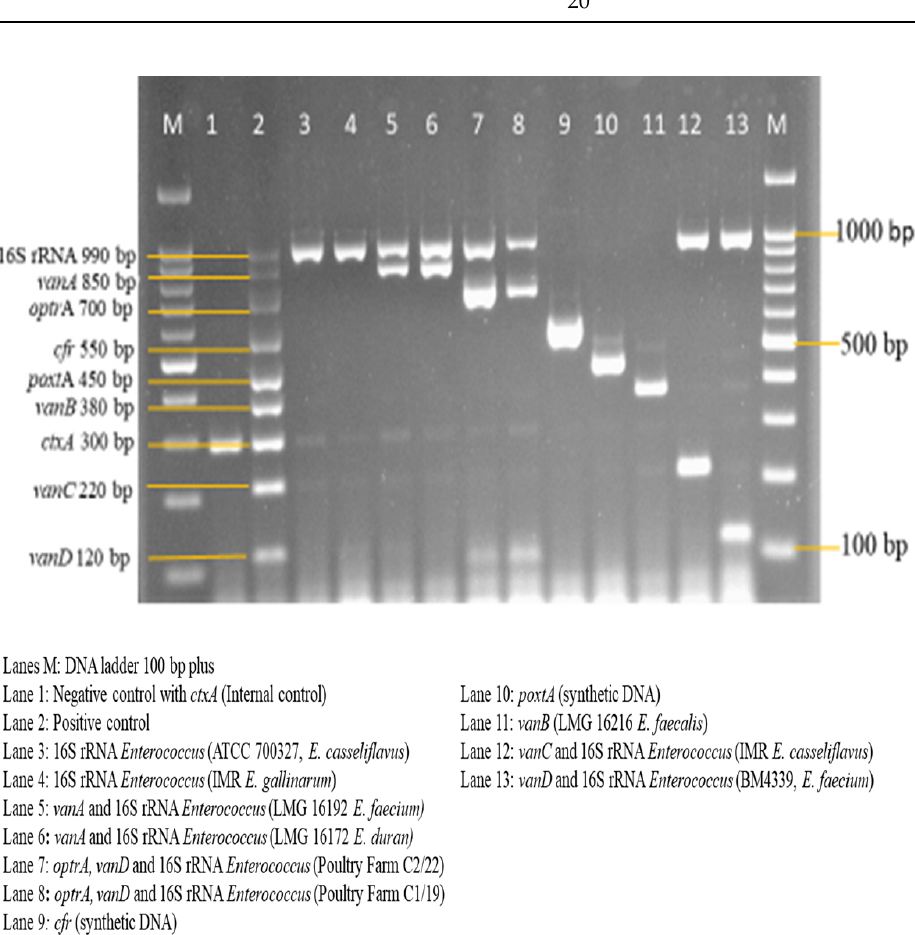
Figure 9. Sensitivity evaluation of multiplex PCR assay on intended reference bacterial strains ( n = 11); 300 bp ctx A doubles as the negative control and IAC on lane 1 while lane 2, with all targets, was designated as the positive control.